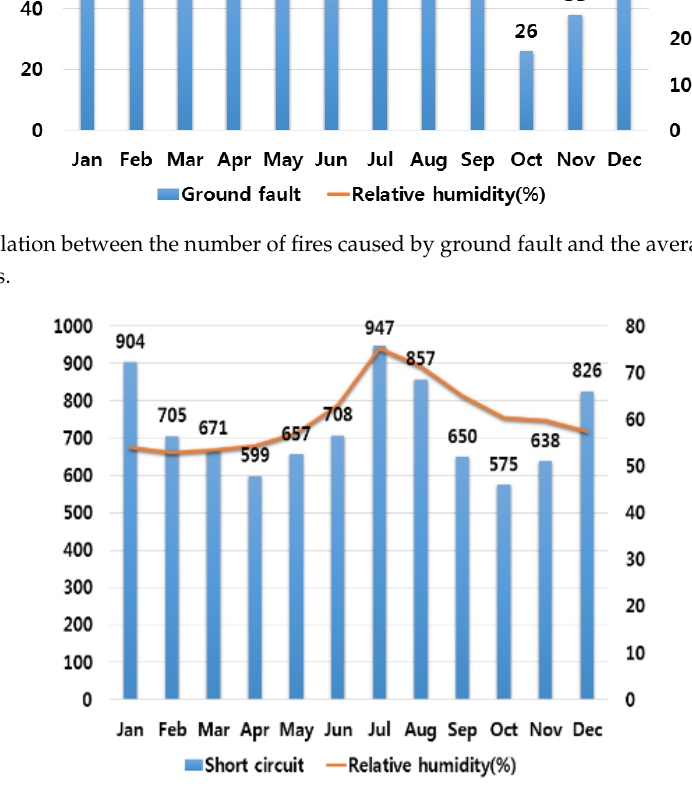
Figure 7. Correlation between the number of fires caused by short circuit and the average humidity on a monthly basis.